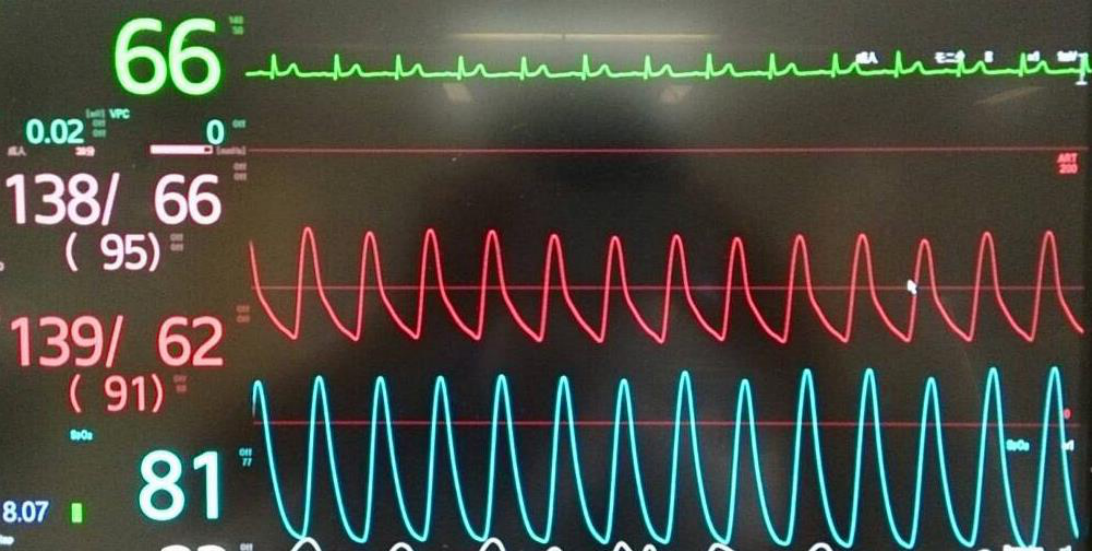
Figure 3. SpO 2 values and other vital signs before the administration of methylene blue.